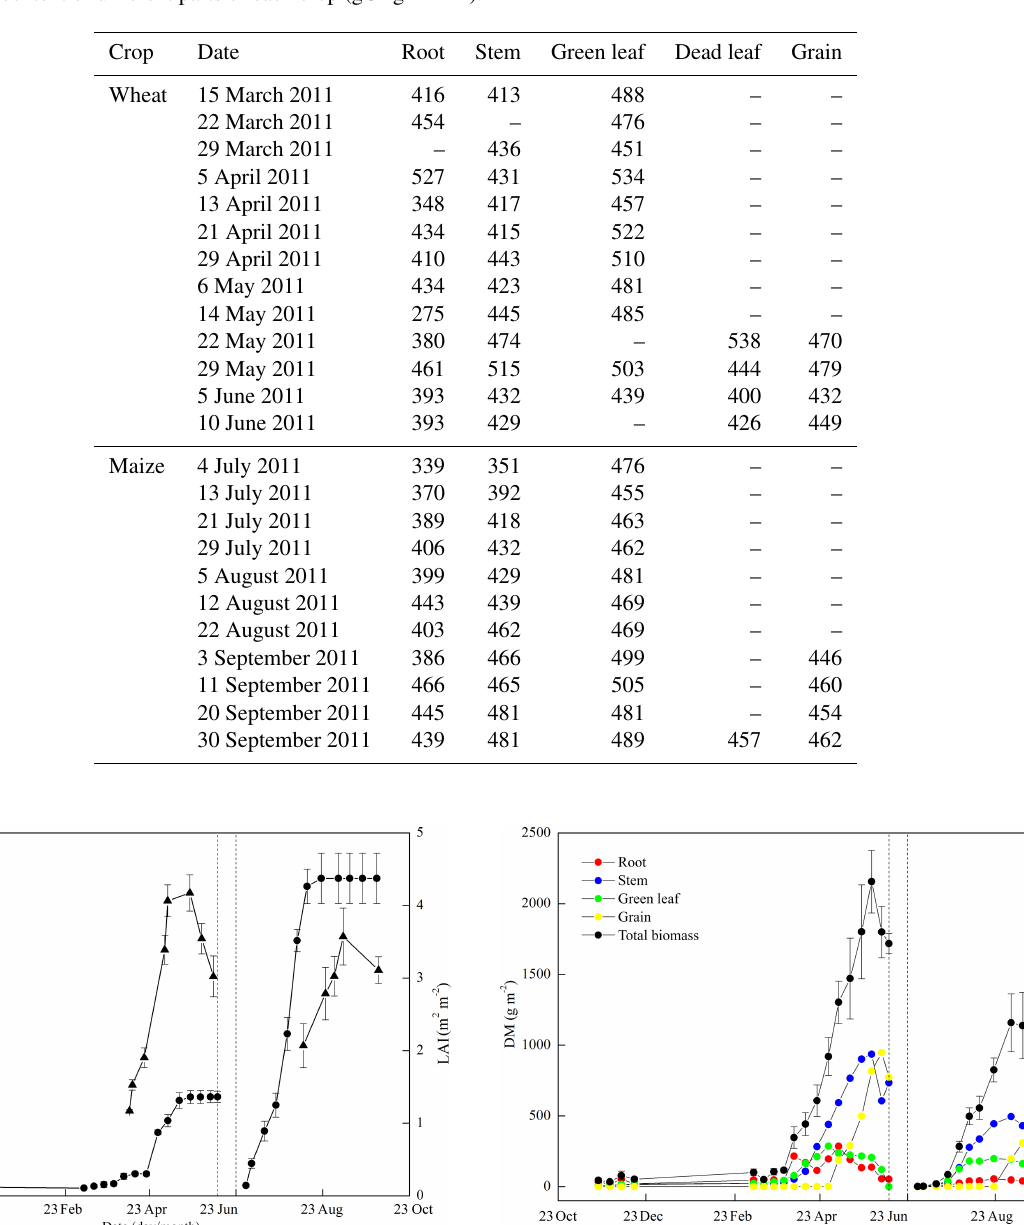
Table 1. Carbon content of different parts of each crop (gCkg − 1 DM).